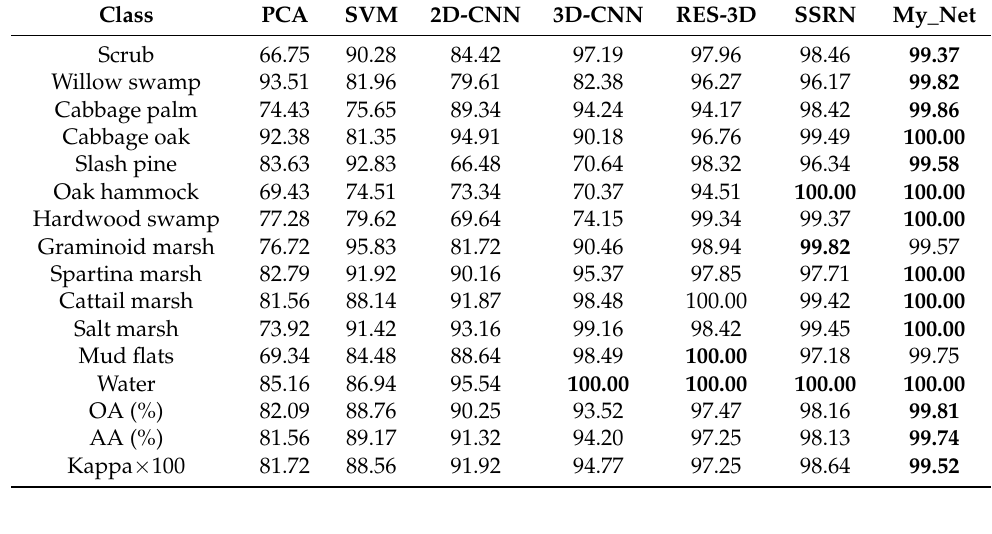
Table 5. Classification results of different models in KSC.